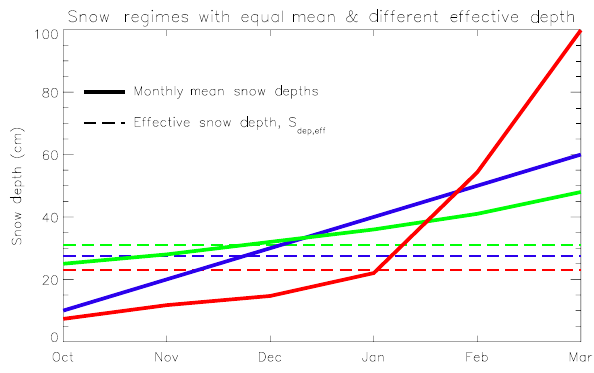
Figure 1. Effective snow depth ( S depth , eff , dashed lines) of three different snow regimes that have equal mean values over the period October–March. Earlier snowfall receives greater weighting as it represents greater insulation; data in green thus have the greatest effective